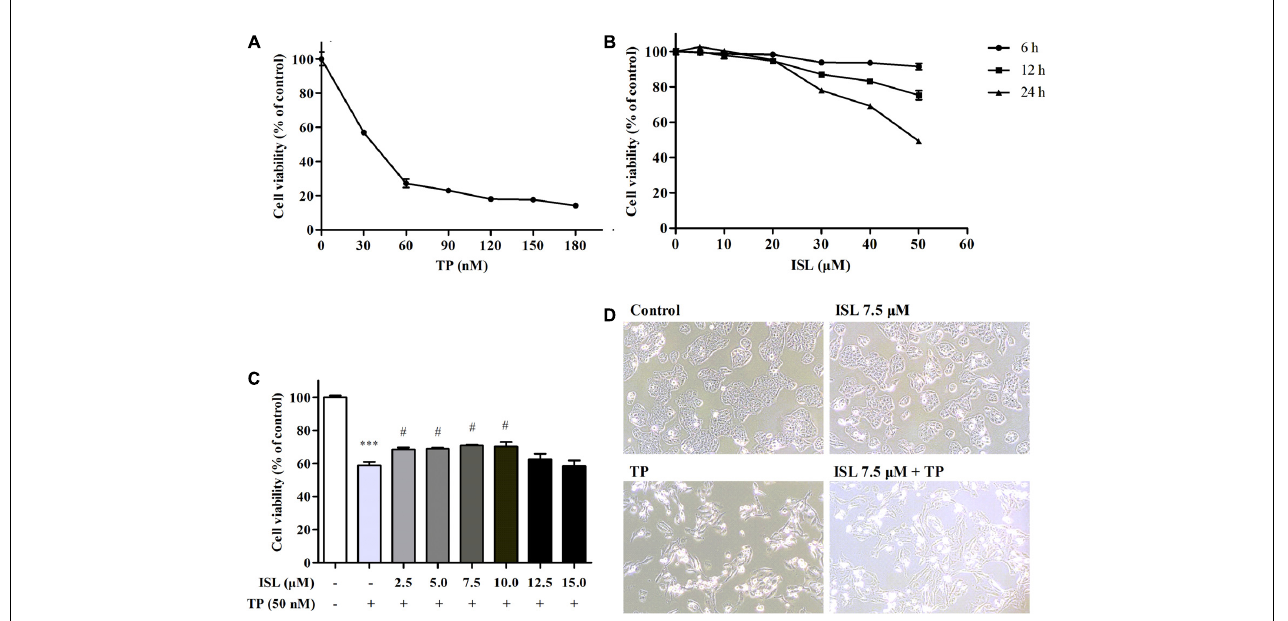
FIGURE 1 | Effects of triptolide (TP), isoliquiritigenin (ISL), or ISL + TP on the viability and morphological changes of L02 cells. (A) L02 cells were treated with TP at various concentrations for 24 h. (B) L02 cells were treated with ISL at various concentrations for 6, 12, and 24 h. (C) L02 cells were pretreated with indicated ISL concentrations for 12 h followed by TP (50 nM, 24 h) treatment. (D) L02 cells were pretreated with 7.5 µ M ISL for 12 h followed by TP (50 nM, 24 h) treatment. Cell morphological changes were detected by a light microscope (10 × magnification). The cell viability was determined by MTT assay. Data were presented as means ± standard error ( SE ) ( n = 3); ∗∗∗ P < 0.001 vs. the control group, # P < 0.05 vs. the TP group, and ### P < 0.001 vs. the TP